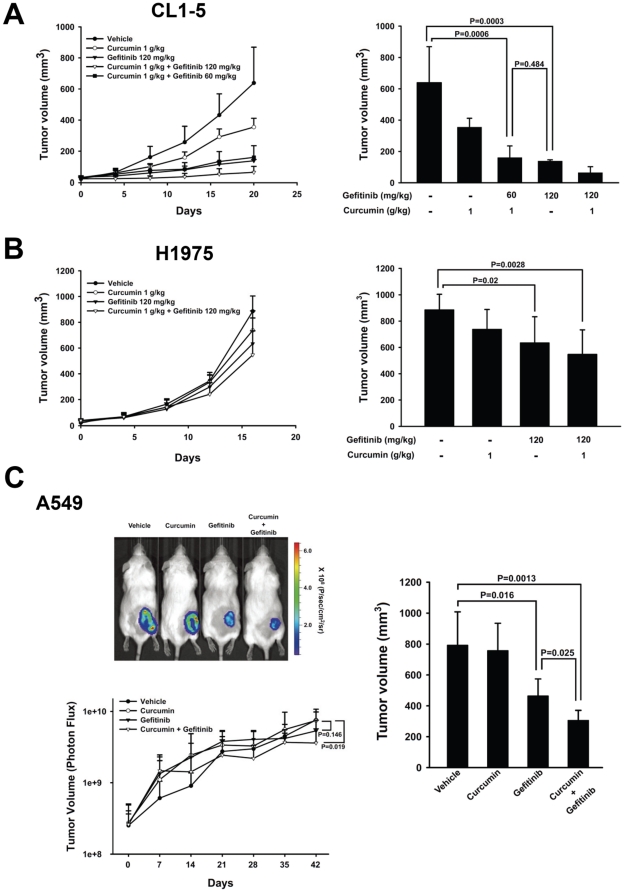
Curcumin sensitizes the effect of gefitinib in inhibiting the growth of gefitinib-resistant NSCLC in SCID mice.(A) left, 106 CL1-5 cells were implanted s.c. in SCID mice and tumor volumes were monitored over time. Points, mean (n = 6); bars, SD; right, tumor volume in CL1-5 xenograft were measured on the last day of the experiment using vernier calipers. Columns, mean (n = 6); bars, SD. P = 0.0003 (control versus gefitinib), 0.0006 (control versus 1 g/kg and 60 mg/kg gefitinib) and 0.484 (1 g/kg and 60 mg/kg gefitinib versus gefitinib). (B) left, 106 A549 xenograft study processed as well as the methods in CL1-5 xenograft. Points, mean (n = 6); bars, SD; right, tumor volume in A549 xenograft were measured on the last day of the experiment using vernier calipers. Columns, mean (n = 6); bars, SD. P = 0.0028 (control versus combination), 0.02 (control versus gefitinib). (C) left, bioluminescence IVIS images of A549 xenograft mice were visualized in anesthetized animals after i.p. inoculation of D-luciferin. The photon flux were measured per second and depicted as the tumor volume at the indicated time using IVIS imaging. Points, mean (n = 6); bars, SD. P = 0.019 (control versus combination), 0.146 (control versus gefitinib). right, tumor volume in H1975 xenograft were measured on the last day of the experiment using vernier calipers. Columns, mean (n = 6); bars, SD. P = 0.0013 (control versus combination), 0.016 (control versus gefitinib) and 0.025 (gefitinib versus combination). The xenograft protocols were detail described in Materials and Methods.